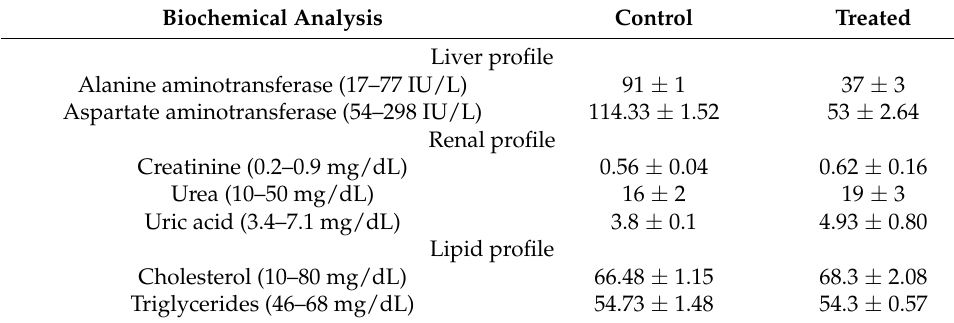
Table 6. Liver, kidney, and lipid profiles of control and treated